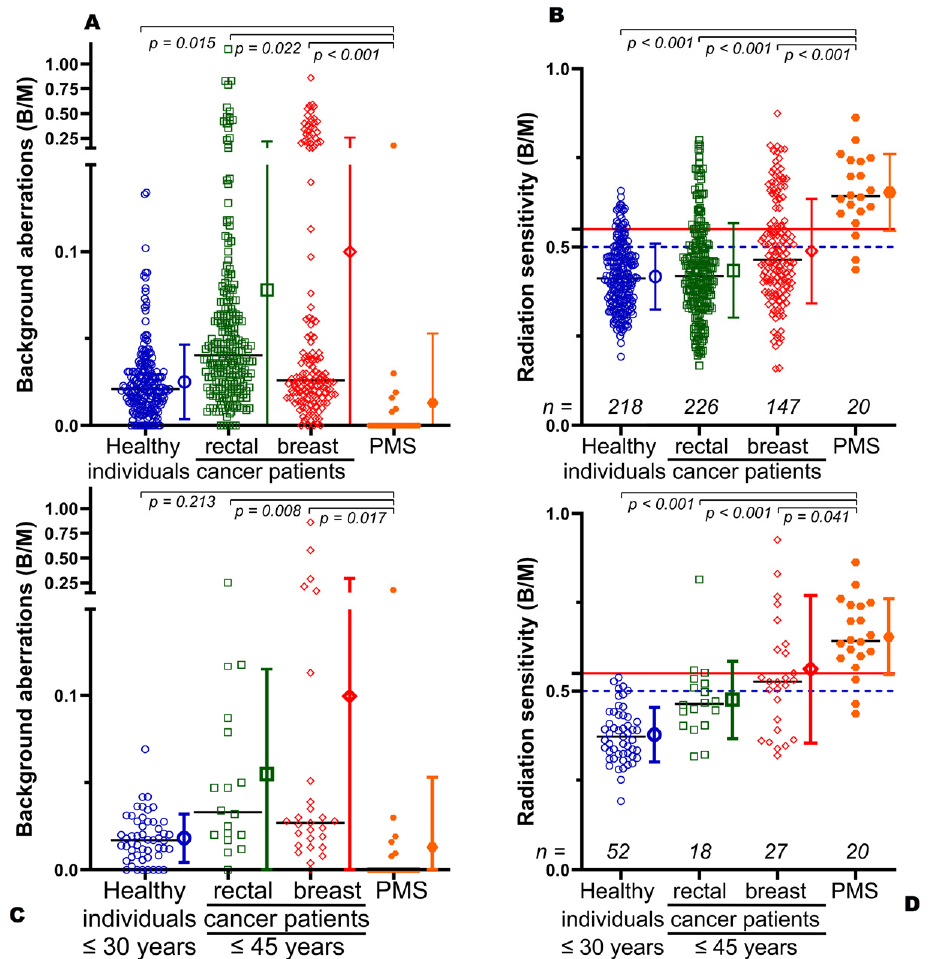
Figure 2. Radiation sensitivity testing in 20 subjects with Phelan-McDermid syndrome. Chromosomal aberrations in ex vivo irradiated lymphocytes from 20 individuals with Phelan-McDermid syndrome compared with a cohort of healthy individuals, patients with rectal cancer and breast cancer. ( A ) Background aberrations of all ages from 9 to 91 years and ( B ) of young healthy individuals younger than or equal to 30 years and cancer patients younger than or equal to 45 years. Chromosomal aberrations after ex vivo irradiation with 2 Gy IR and subtraction of background aberrations give ( C ) radiation sensitivity of the whole cohort or ( D ) young individuals. B/M = Breaks per metaphase. The dashed blue line indicates individuals with increased radiation sensitivity and the solid red line indicates individuals with significantly increased radiation sensitivity. Table 3. Radiation sensitivity in the different cohorts.